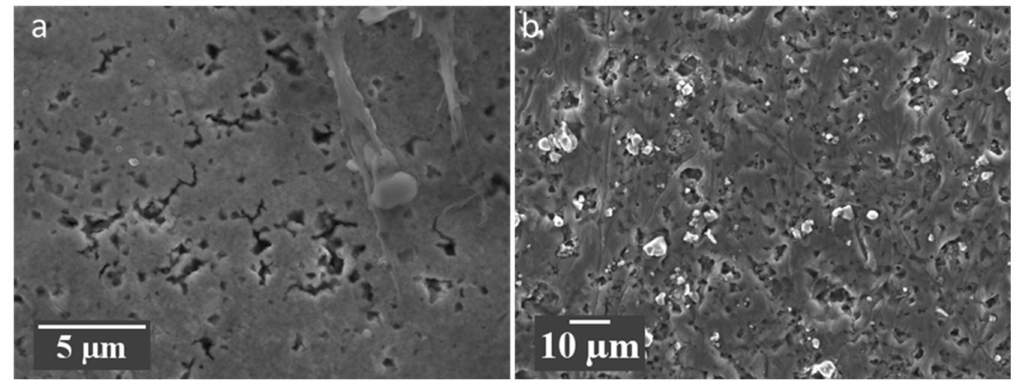
Figure 5. Scanning electron microscopy (SEM) images of copper ( a ) and aluminum ( b ) current collectors obtained from the QC reject